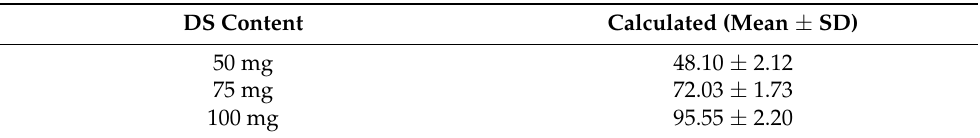
Figure 6. Predicted content of DS in the test set alongside deviation (boxplots). The statistical outcomes of the PLS model are also shown. Table 1. The mean DS content of the tablets (N = 36) as specified in the patient’s leaflet and the corresponding calculated values of the same tablets’ DS content based on the PLS